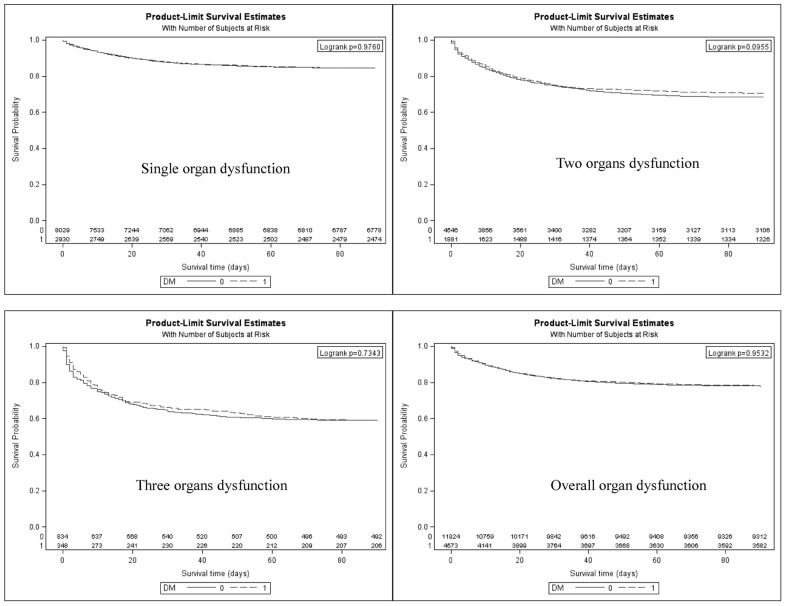
Kaplan-Meier survival curves in diabetic and non-diabetic patients with severe sepsis by number involvement of organ dysfunction. Log-rank test was used for comparing their survival.